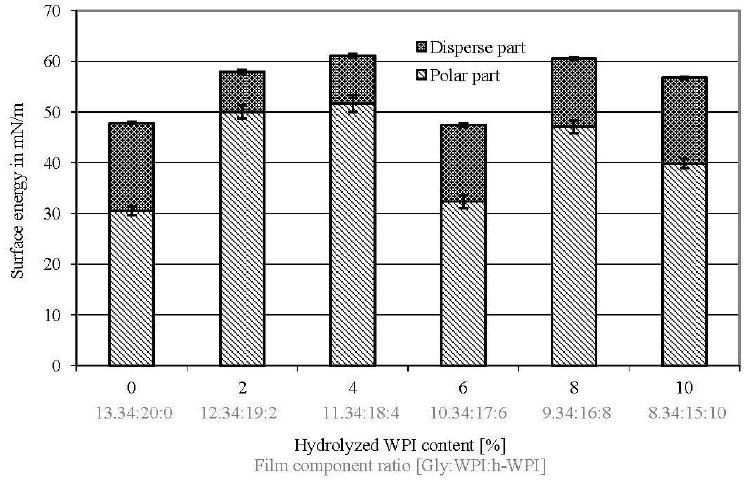
Figure 6. Effect of increased h-WPI content (reduced protein M content on the disperse part, polar part and total surface energy of WPI-based